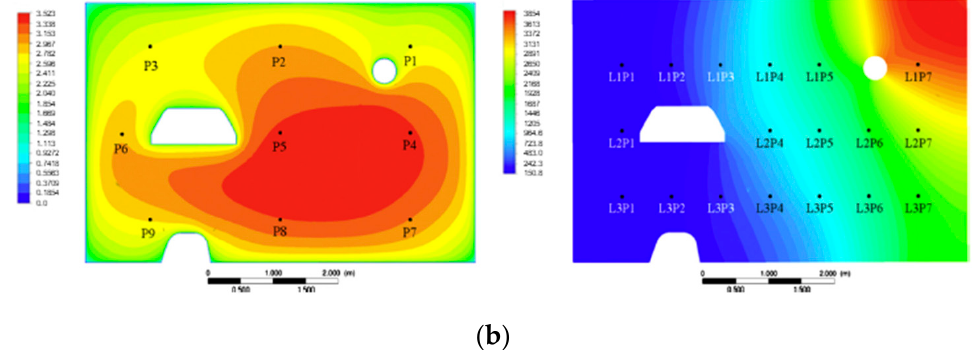
Figure 6. ( a ) a portion of the calculated grids for the cross-section of tunnels made of both tetra- and hexa-dominated grids ( b ) CFD results of the velocity profiles(m/s) and SF 6 distribution(ppb) in the cross-section of mine tunnels [23]. (Adapted with permission from ref. [23]. Copyright 2015 Elsevier Ltd.).